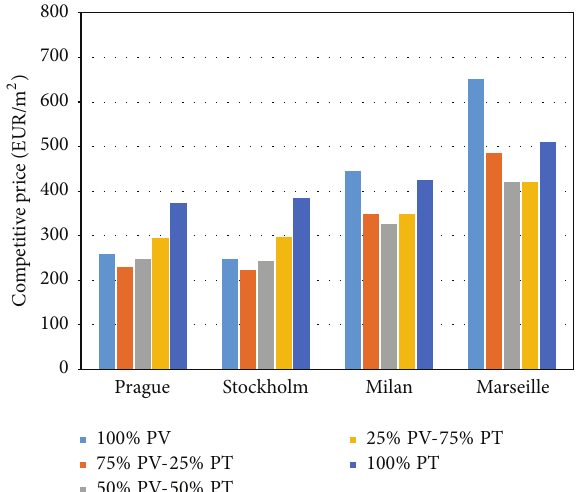
Figure 8: Competitive specific price of glazed nonselective hybrid PVT collector.